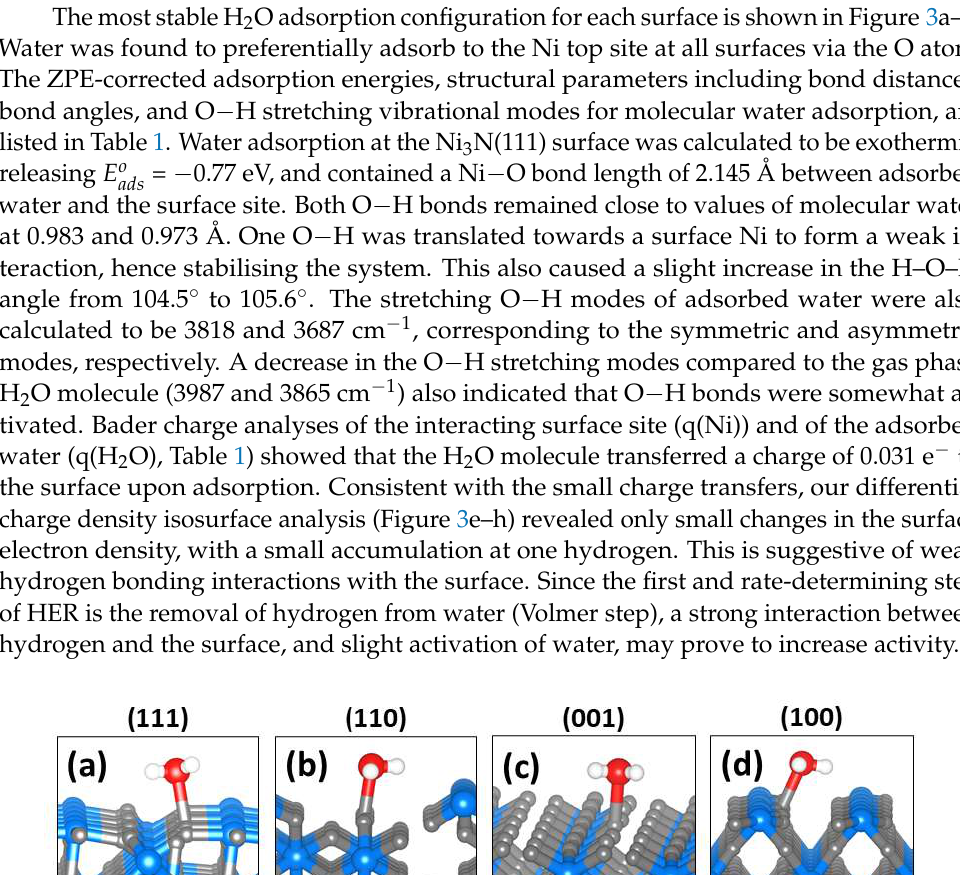
). Each image is ads